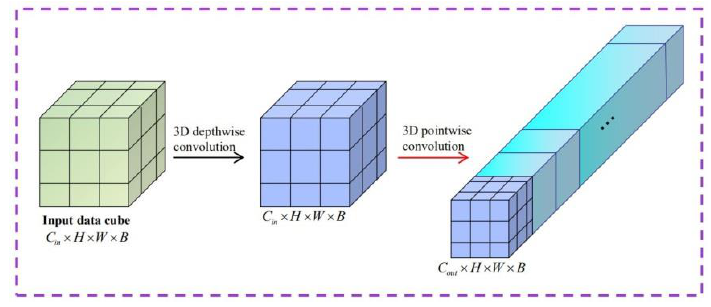
Figure 2. The proposed 3D-DW module.